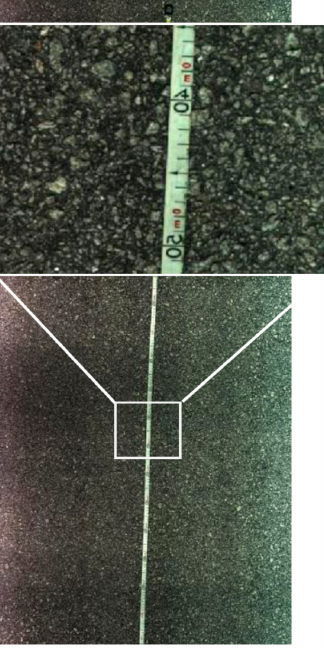
Figure 8. Set of stitched images with a scanned tape measure on the road and a particular zoomed area showing sub-millimeter resolution.